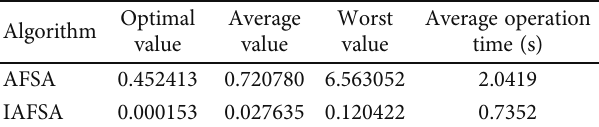
Table 6: Execution results of two optimization algorithms (function f 3 ).